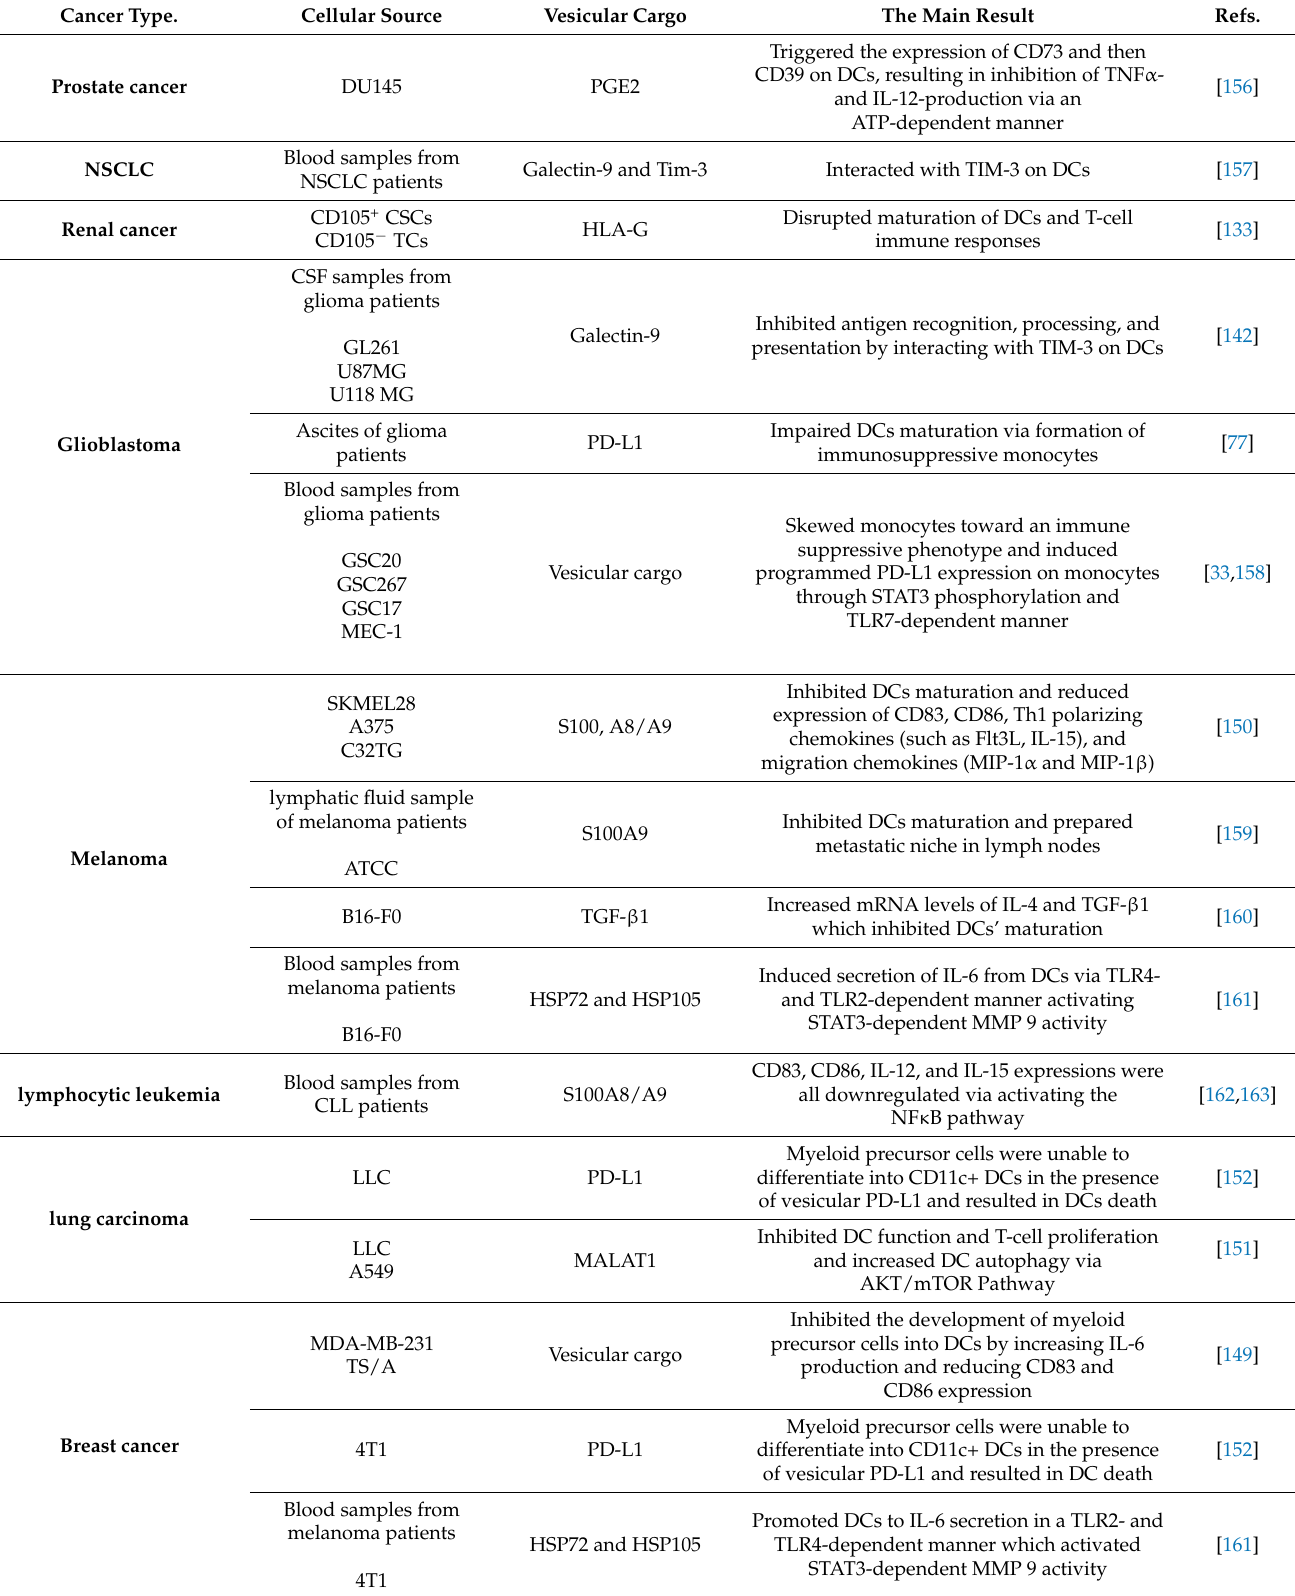
Table 4. Effect of the tumor-derived extracellular vesicles on Dendritic